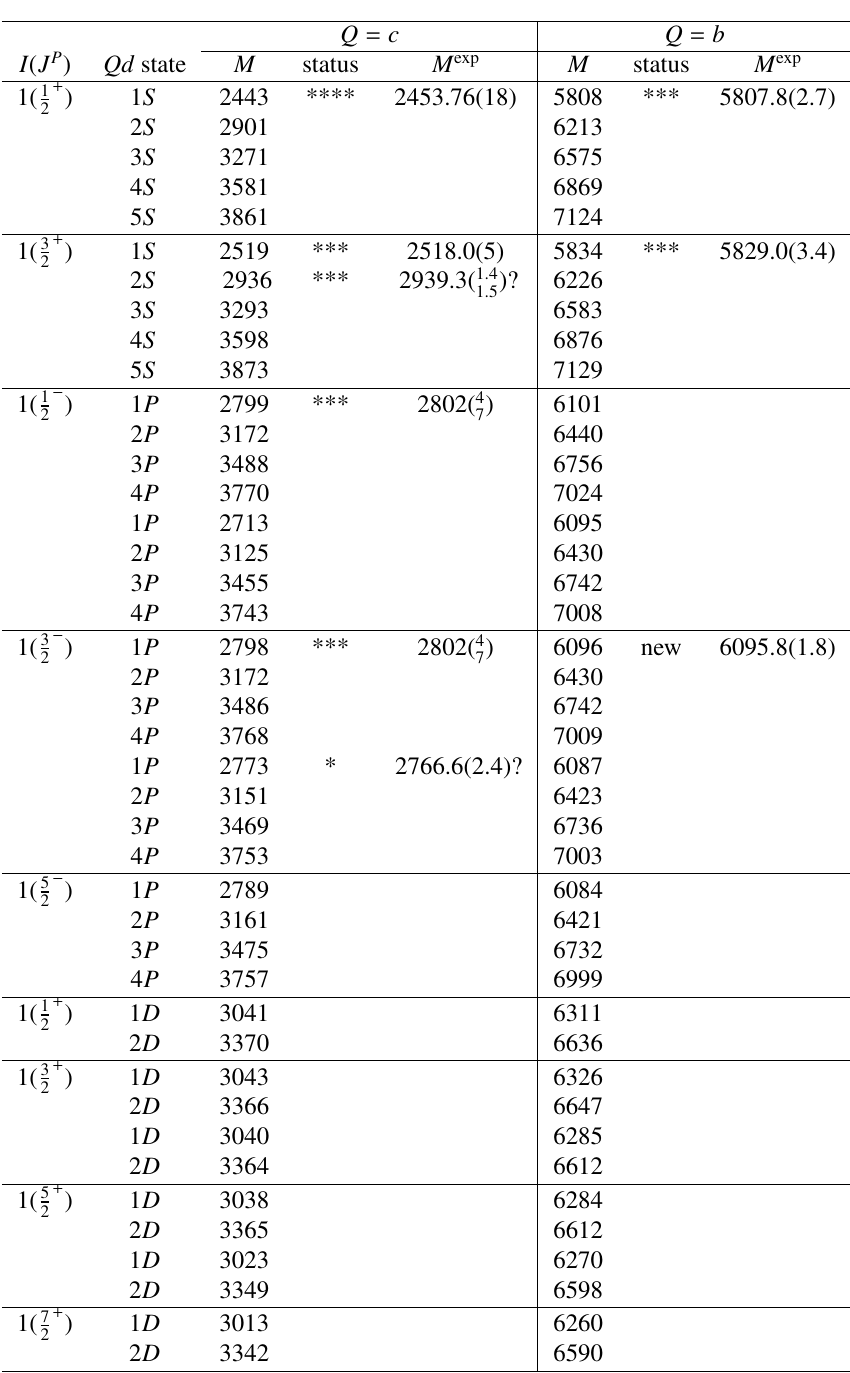
Table 2. Masses of the Σ Q ( Q = c , b ) heavy baryons (in MeV) Q = c Q =